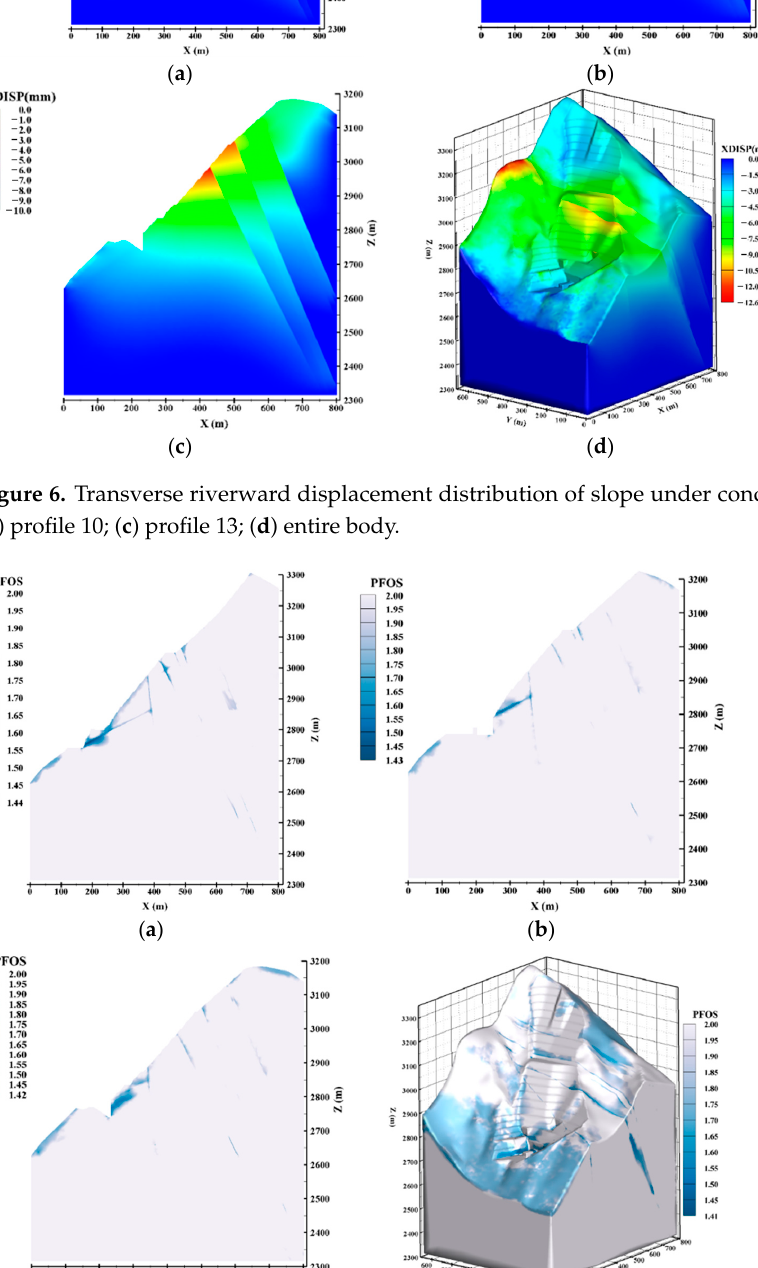
Figure 7. Point factor of safety distribution of slope under condition I. ( a ) Profile 5; ( b ) profile 10; ( c ) profile 13; ( d ) entire body.